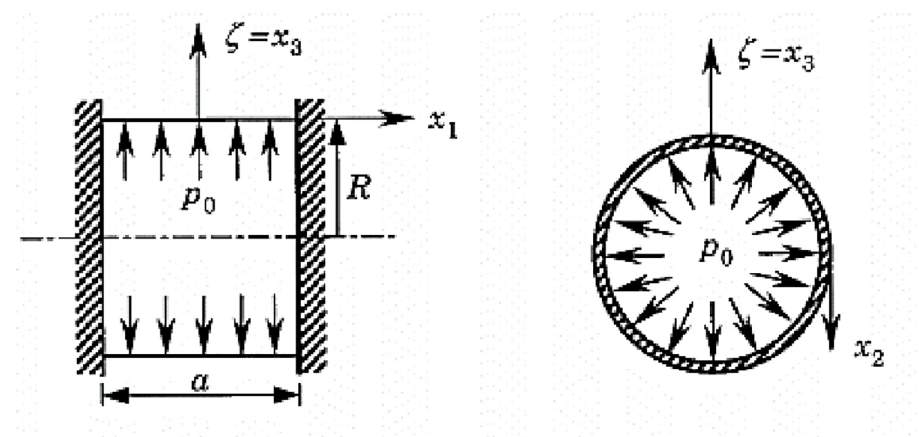
Fig 8. Cylindrical laminate shell with embedded-ends under internal pressure.